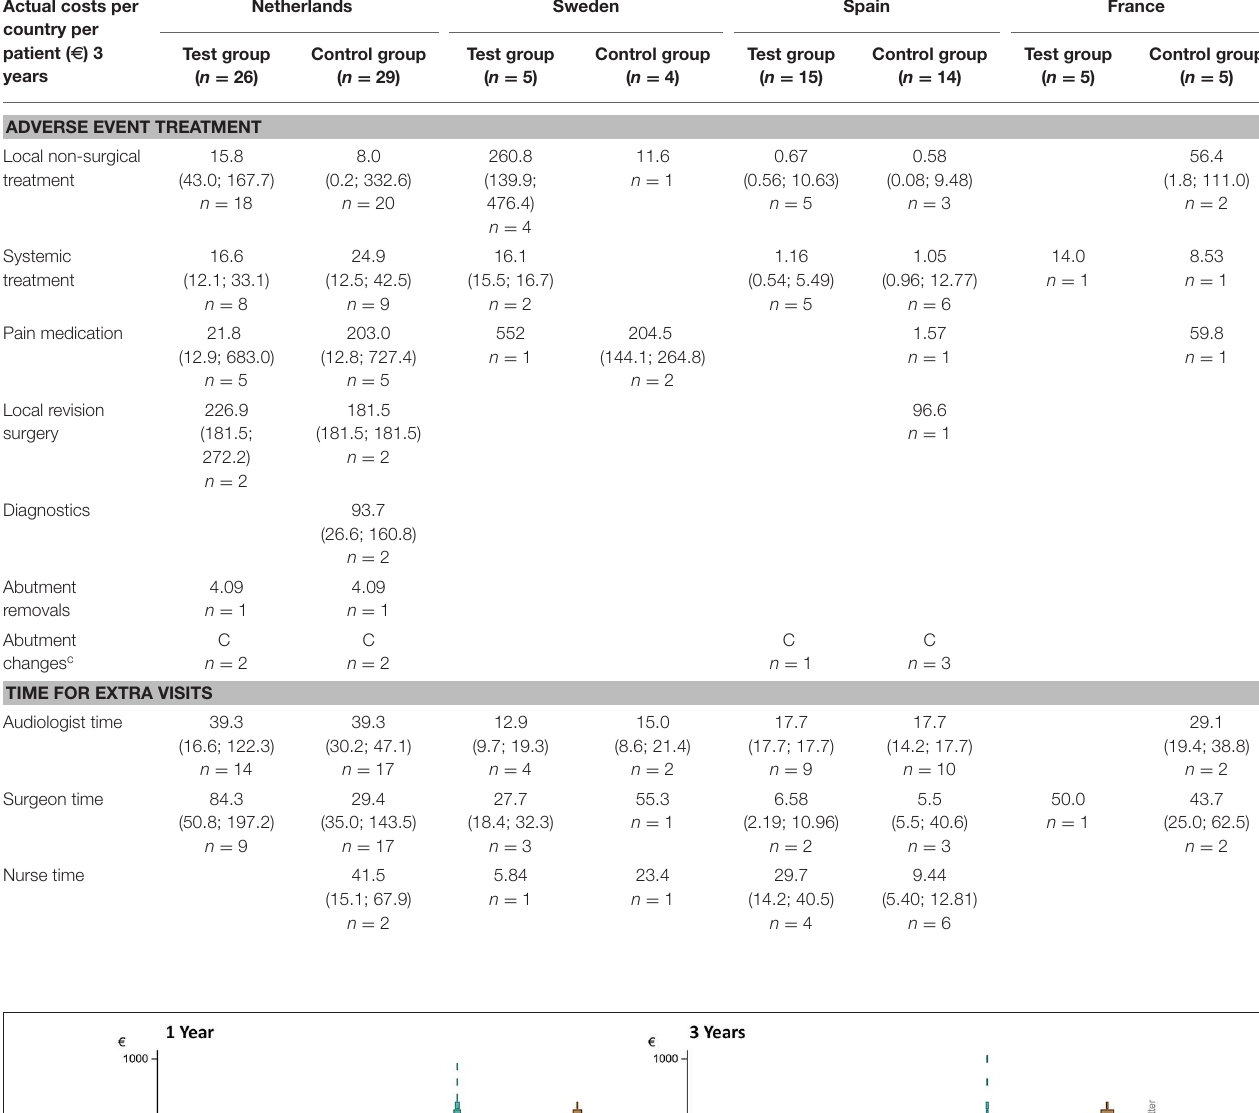
TABLE 4B | Costs per country after 3 years.